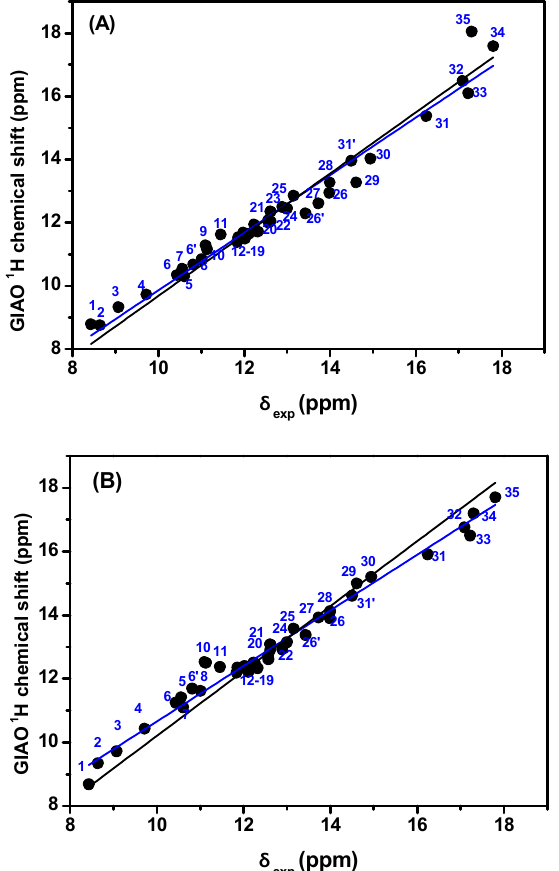
Figure 10. Calculated (at the GIAO/B3LYP/6-311G+(2d,p) level of theory with CPCM in CHCl 3 ) vs. experimental chemical shifts of the OH protons of the compounds 1–35 of Figure 9 with minimization of the structures at the M06-2X/6-31+G(d) ( A ) and B3LYP/6-31+G(d) ( B ) level of theory, respectively. The blue line corresponds to the linear fit and the black line to the linear fit through the zero. Reprinted, with permission, from [47]. Copyright 2015, The Royal Society of Chemistry .